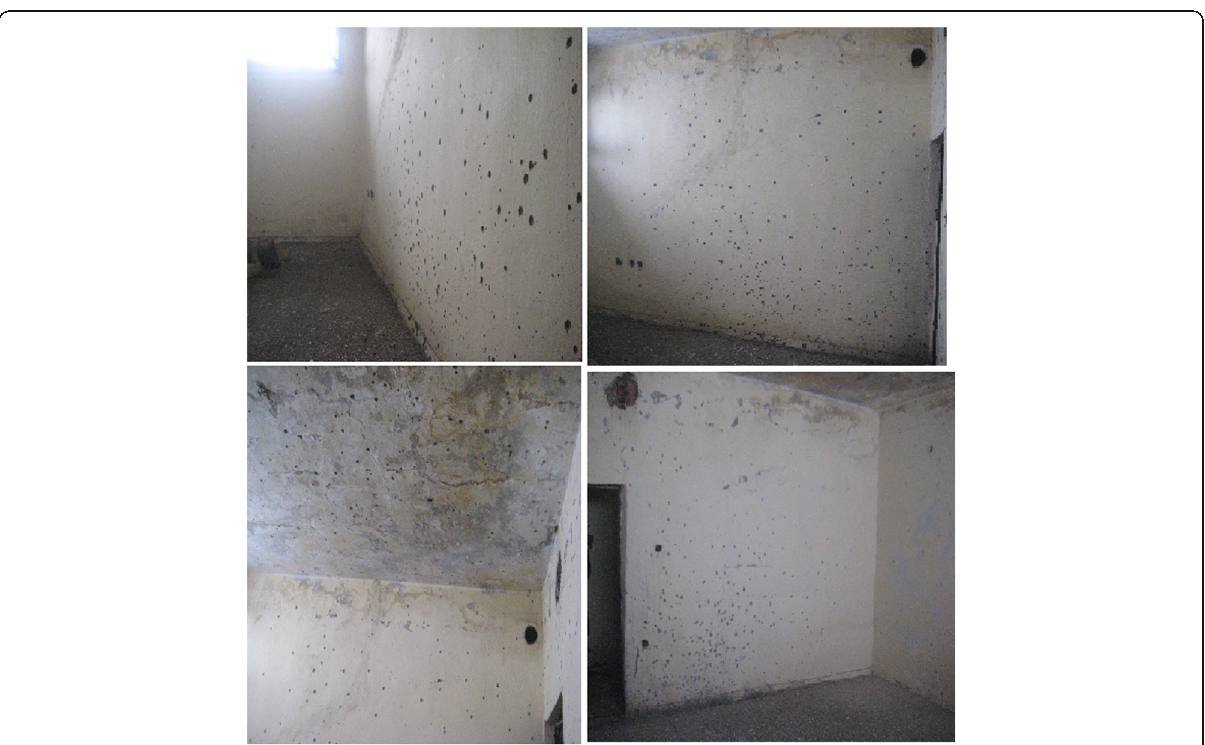
Fig. 12 Shrapnel effects observed in test room walls and ceilings after